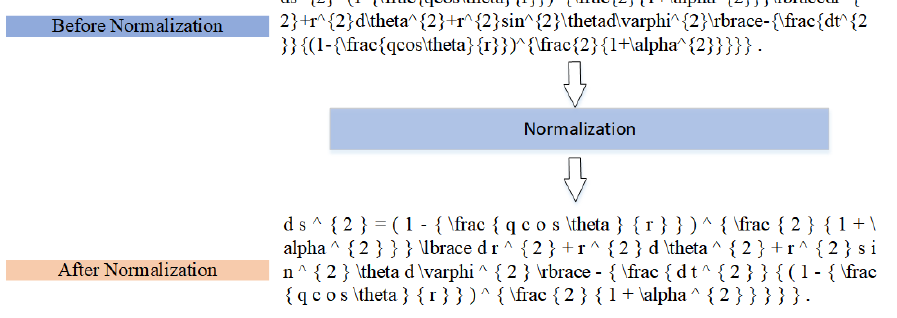
Figure 7. LaTeX sequence normalized output.